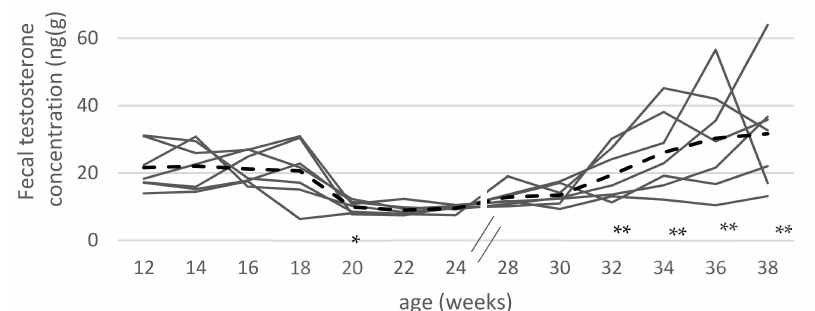
Figure 1. Individual (-) and mean (- -) fecal testosterone concentrations (ng / g) of animals in the long term follow-up group IC-12 / 18X ( n = 7) from 12th to 38th week of age; * indicate significant ( p < 0.05) di ff erences compared to two weeks earlier; ** indicate significant di ff erence to testosterone concentration compared to week 30.